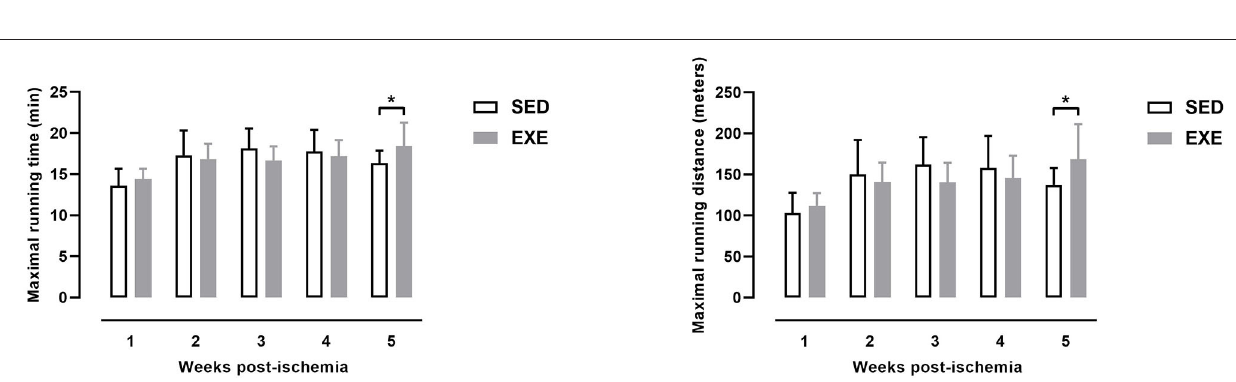
FIGURE 1 | Effect of wheel exercise before induction of PAD in ApoE − / − mice. (A) Daily distance ran each week by EXE mice ( n = 11). (B) Body weights of EXE and SED mice ( n = 11 animals per group). (C) Maximal running distance (left) and maximal running time (right) as measured on a graduated treadmill running test ( n = 11 animals per group). Repeated measures one-way ANOVA with Tukey’s multiple comparisons test in (A) : $$ p < 0.01 vs. week 1. Unpaired t -test in (B,C) : * p < 0.05, ** p < 0.01, **** p < 0.0001 vs. SED. Bar graphs represent mean ± SD.